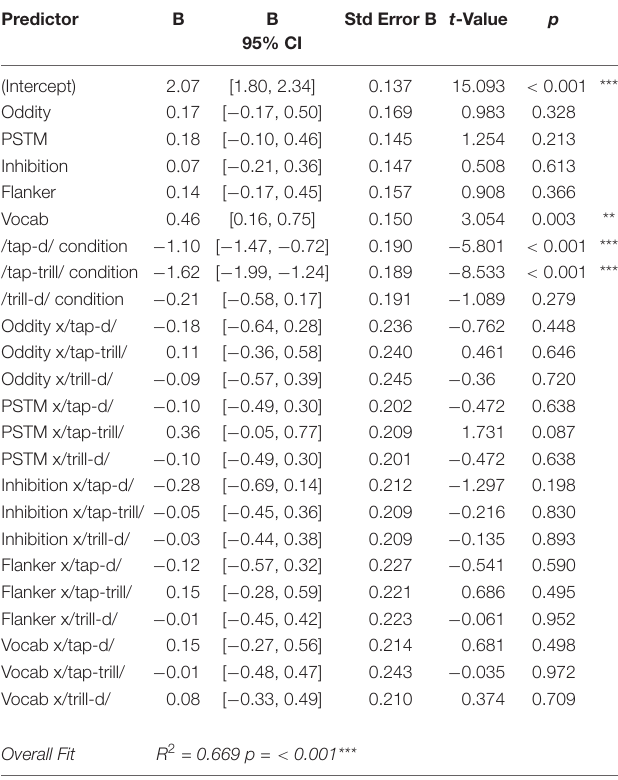
TABLE 3 | Summary of regression analysis for lexical decision, all